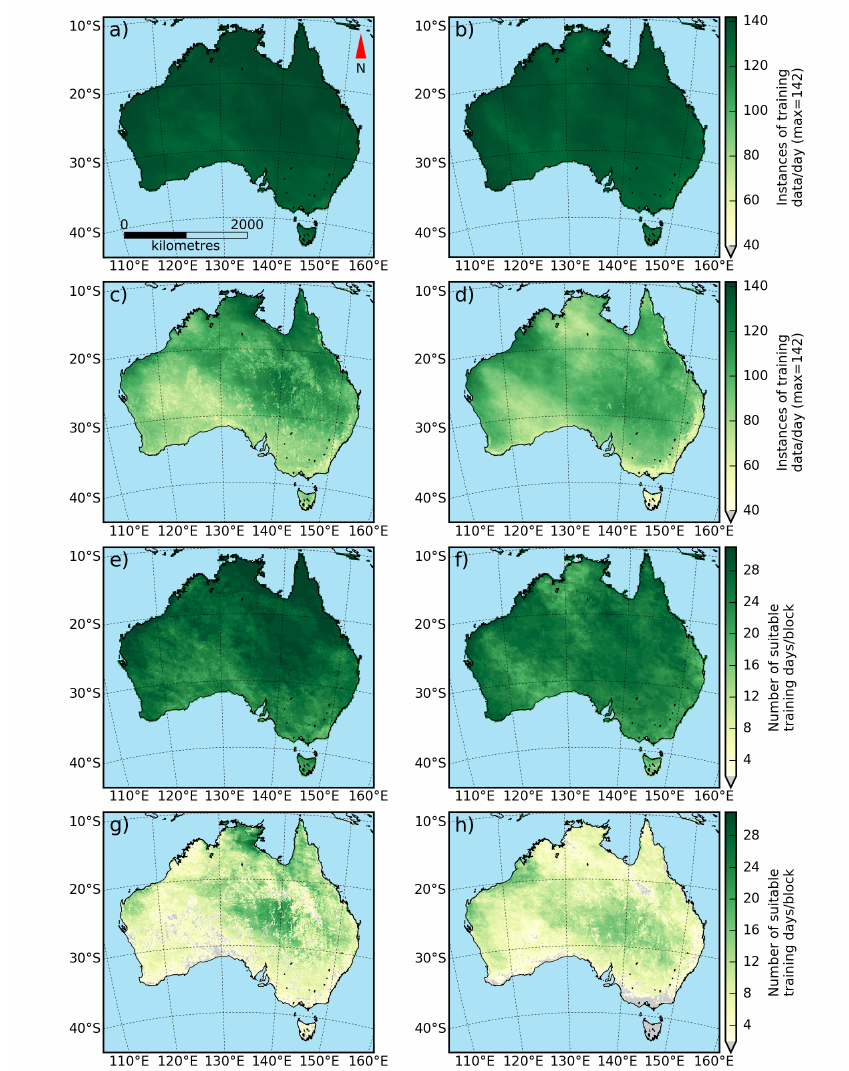
Figure 5. Availability of training data from the block and pixel based methods. ( a , b ) show the mean instances of training data available using the BAT method for October and November respectively; ( c , d ) show the training data available using the pixel method for the same months. ( e , f ) demonstrate the number of 24-h periods that could be utilised as training data for each block in October and November, and ( g , h ) show this same criteria using the pixel based